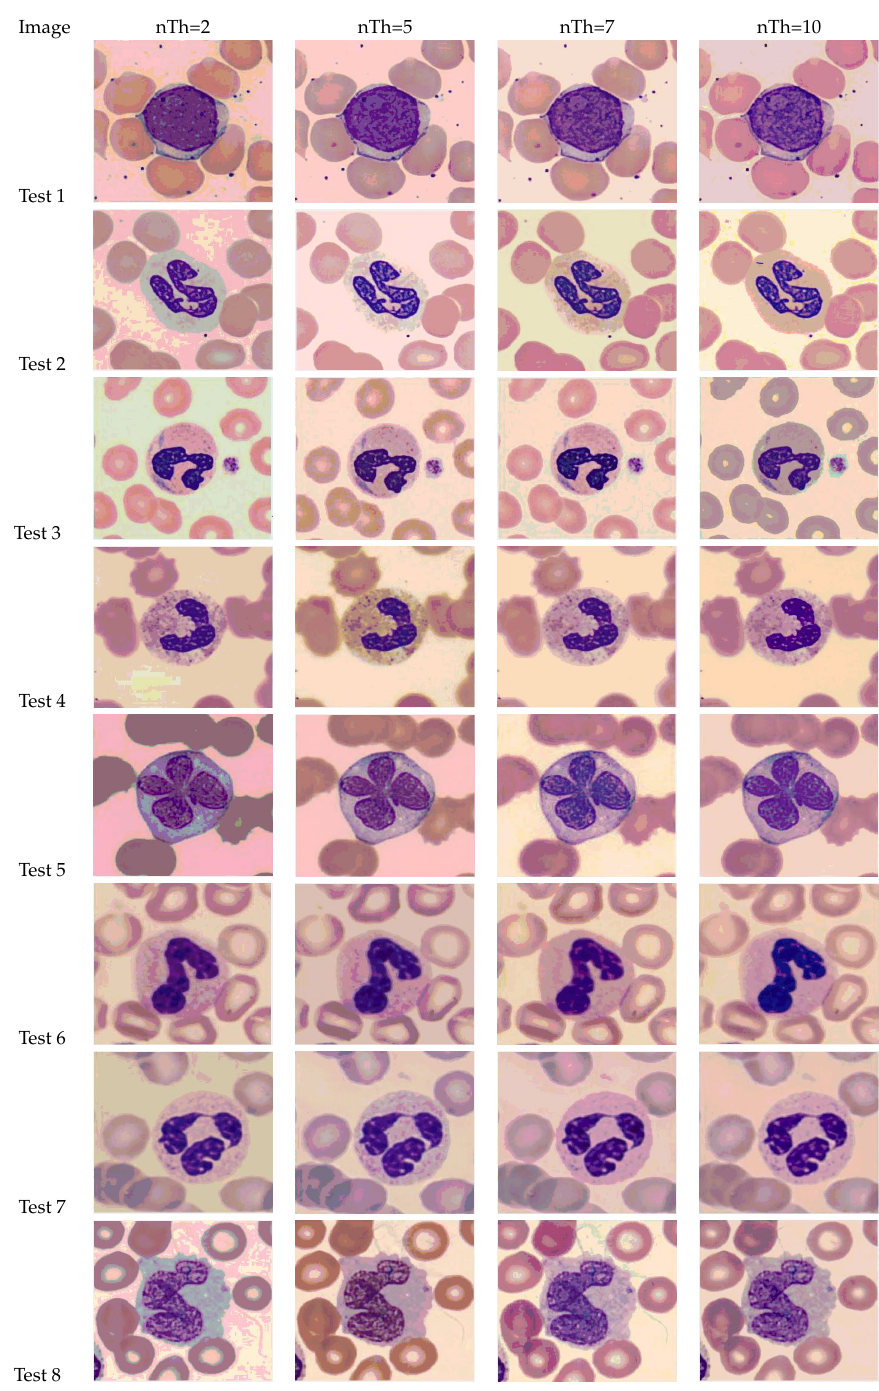
Figure A1. Outcomes after executing mSAR on Fuzzy Entropy’s method over the set of test